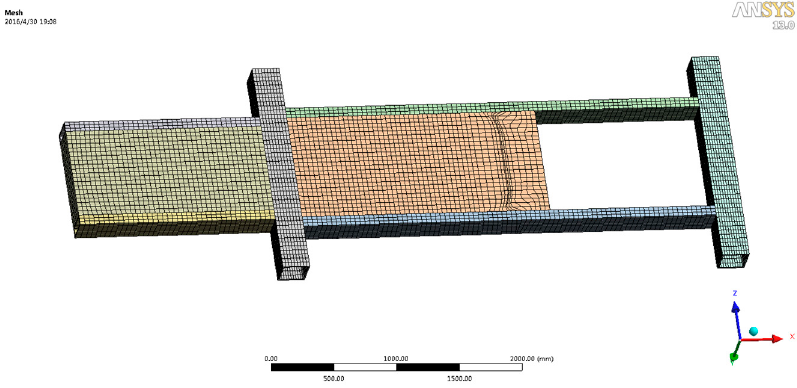
Figure 10. Topology-optimized finite element model.